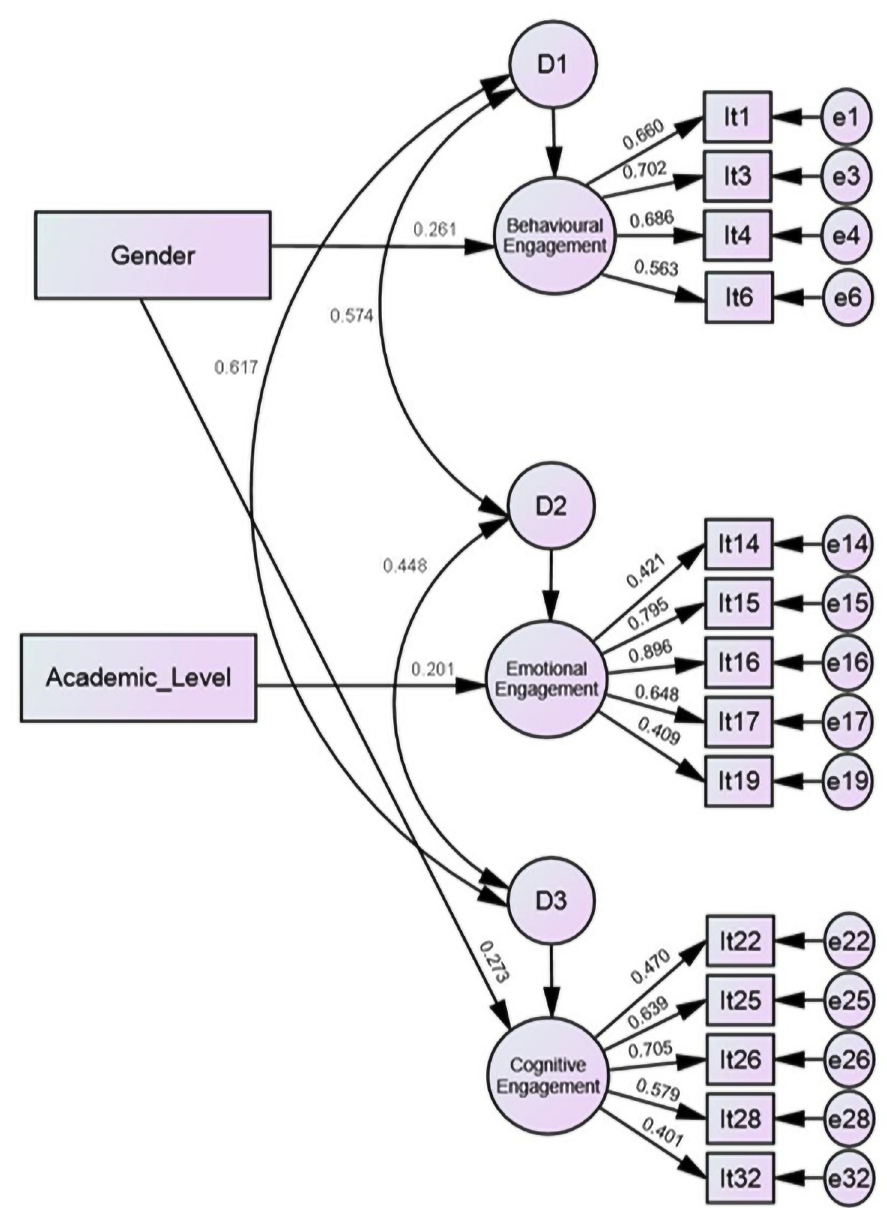
Fig 2. Structural model of variables with a significant contribution (p < 0.05) to university engagement in the USA